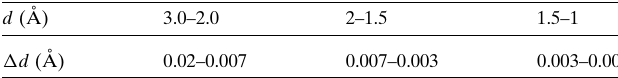
Table 2 Error in determining interplanar distances.